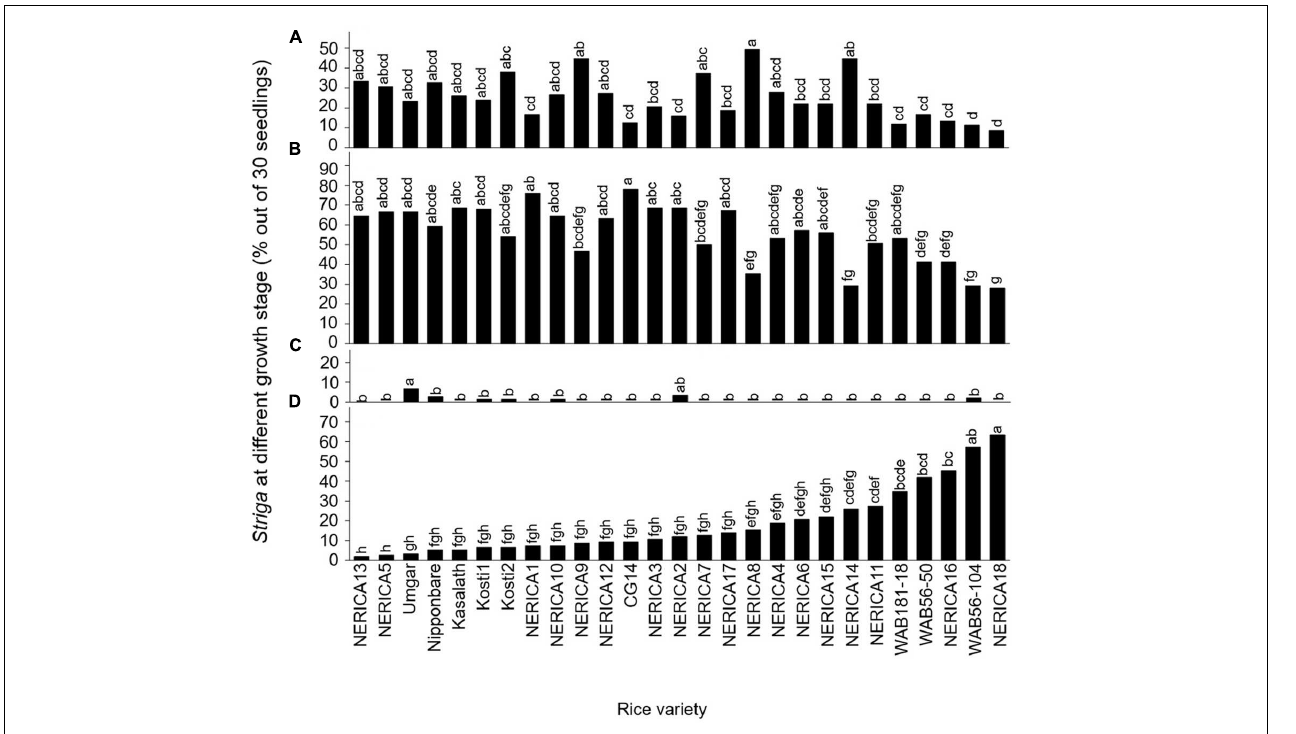
FIGURE 2 | Percentage out of 30 seedlings of S. hermonthica at stage (A) I, failure to attach to the root due to a lack of haustorium formation (Figure 1a); (B) II, successful attachment but no shoot elongation (Figures 1b–d); (C) III, shoot necrosis after reaching the four or more leaf